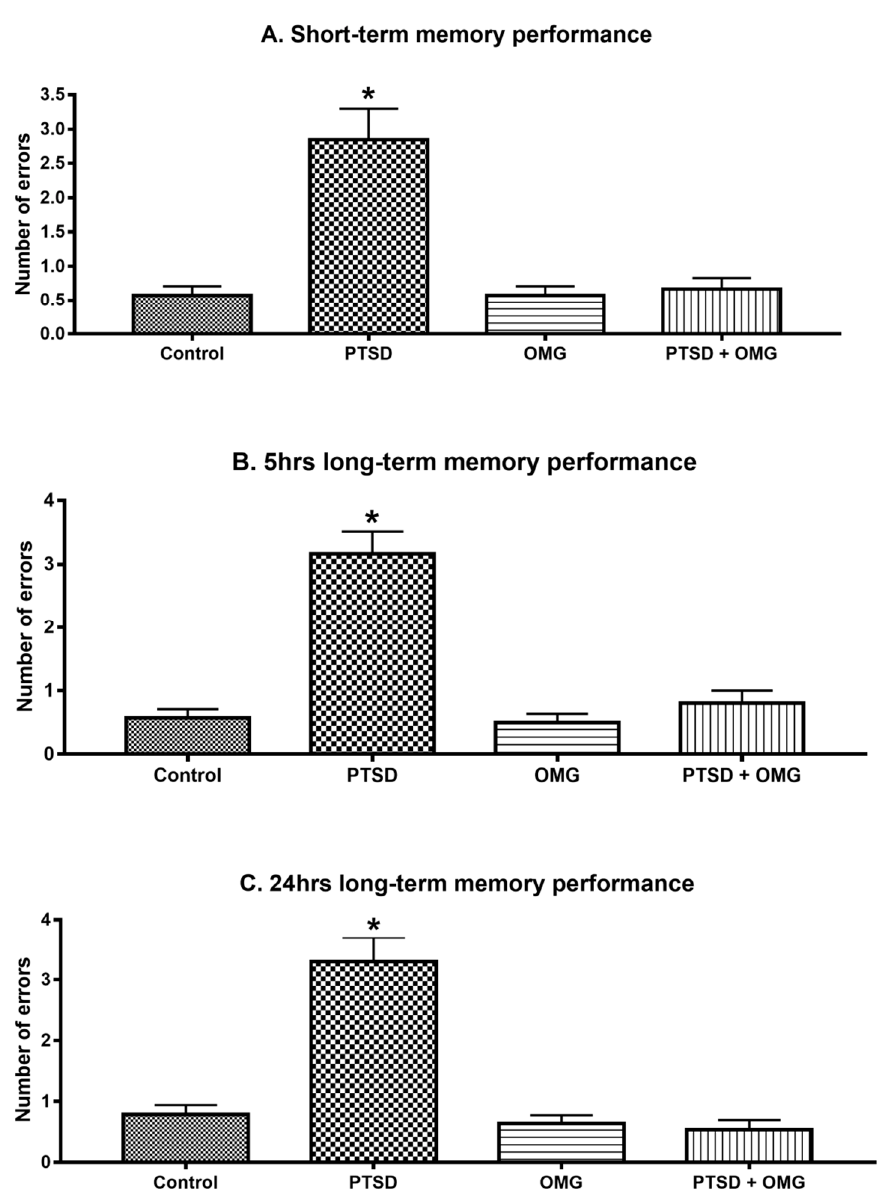
Figure 2. Omega-3 prevents short- and long-term memory impairment induced by the SPS model of PTSD. ( A ) Short-term memory test (trial after 30 min), ( B ) and ( C ) long-term memory tests after 5 h and 24 h, respectively, among control, PTSD, OMG, and PTSD treated with OMG (PTSD + OMG) groups. * Indicate significant difference from all other groups ( p < 0.05). Each point is the mean ± SEM of 15 animals.